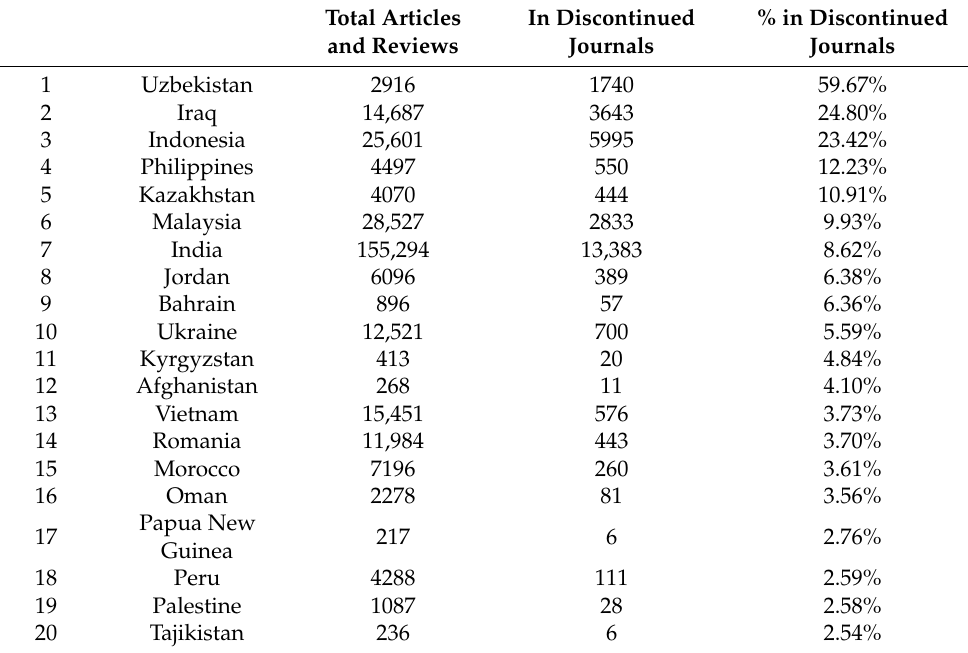
Table 1. Percentage of articles and reviews by countries in sources discontinued by Scopus in 2020. Total